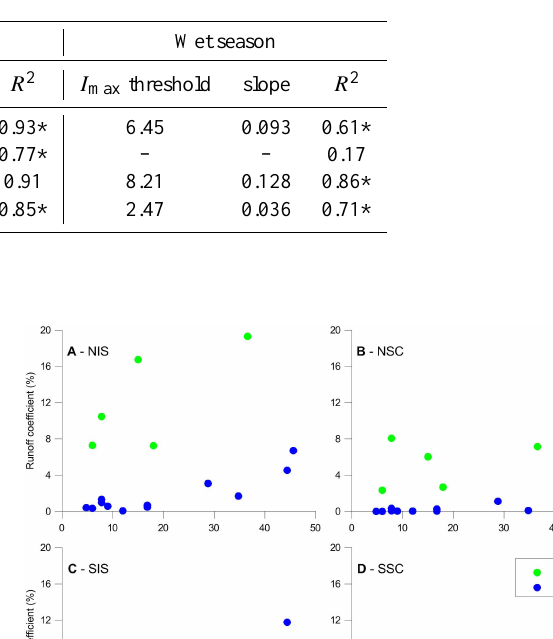
Table 5. Relevant parameters of the regression models performing the relation between I max and R r . I max threshold is the I max necessary to generate runoff.